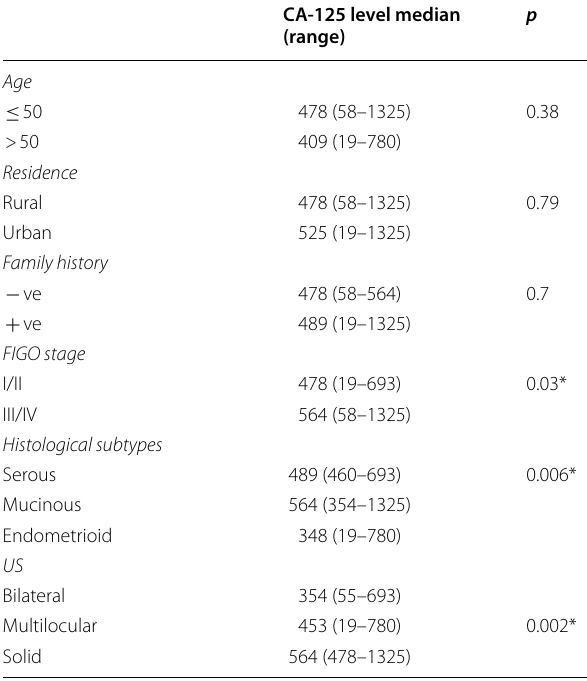
Table 5 Relationships among serum CA-125 level and clinicopathological parameters in ovarian cancer patients